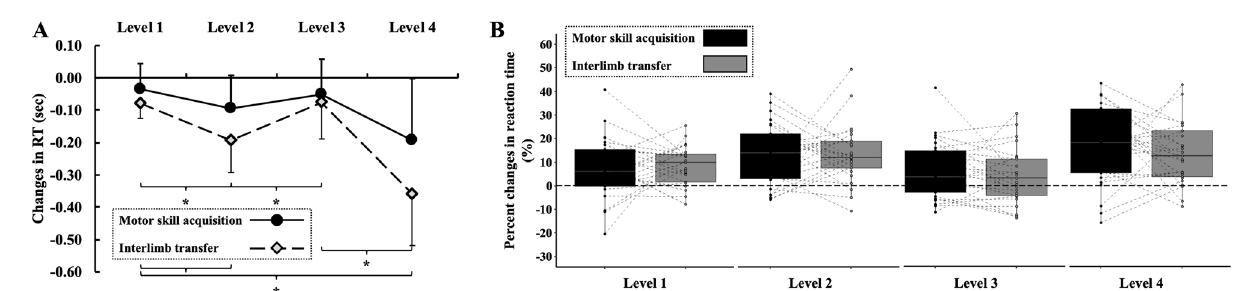
Figure 5. Changes in participants’ reaction time. Panel ( A ) Participants’ RT improved the most at the most complex finger tapping sequence task for both motor skill acquisition (black circles) and interlimb transfer (grey diamonds), regardless of handedness. Symbols and vertical bars denote mean values ± 1SD. Panel ( B ) No differences were found in the level of motor skill acquisition (black boxes) and interlimb transfer (grey boxes) at any complexity levels. Dotted lines between boxes represent the percent changes of motor skill acquisition and interlimb transfer of the same participant. Larger values than zero correspond to better post-intervention reaction times as compared to baseline values. The boxplots show the median, the upper, and lower quartiles, and the min and max value of the groups. “ × ” within the boxplot represents the mean line. * p <